Question: What form of chart is displayed?
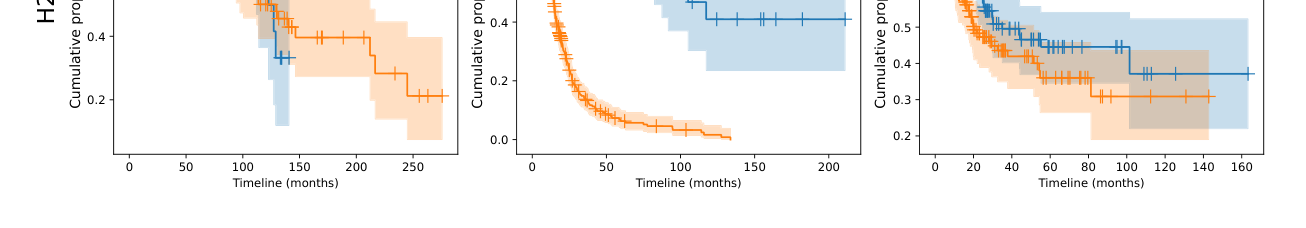
Answer: survival